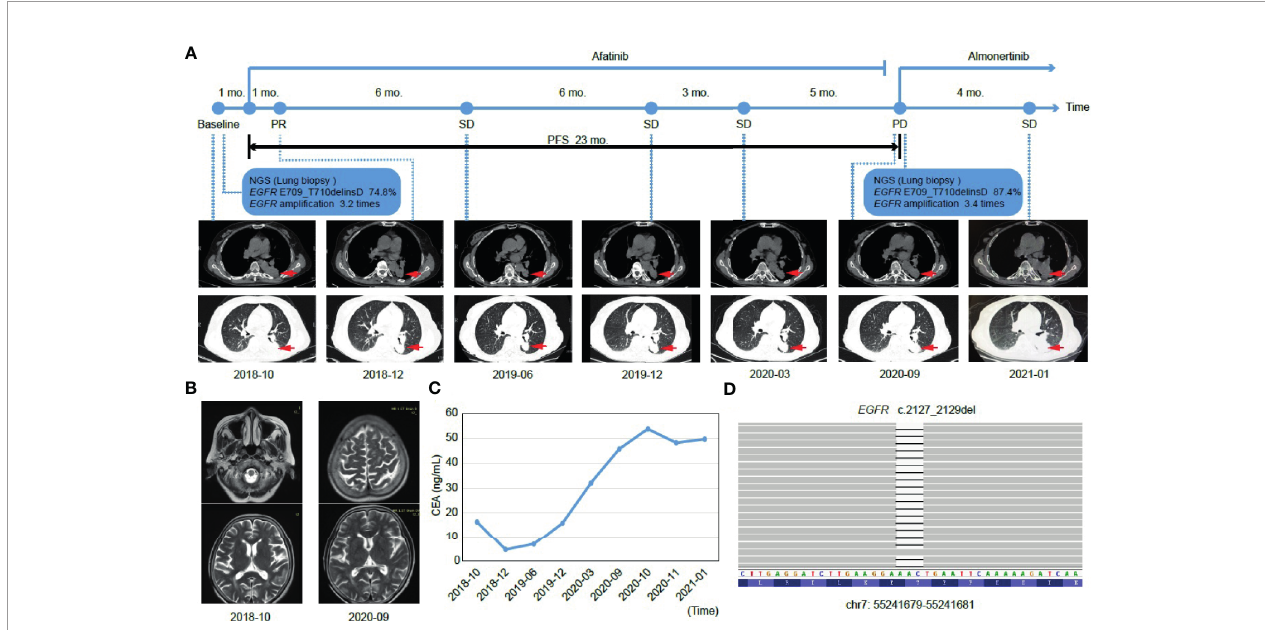
FIGURE 1 | Tumor progression of the patient before and after treatment. (A) The timeline of therapies and tumor progression are indicated (Top). CT images revealed lesions in lower left lung. The tumor is indicated by red arrows. PFS, progression-free survival; PR, partial response; SD, stable disease; PD, progressive disease; NGS, next-generation sequencing; mo., months. (B) Brain MRI scans revealed no metastasis before (October 2018) and after (September 2020) treatment. (C) Line chart showing changes in the levels of the serum tumor biomarker, CEA (carcinoembryonic antigen) during the course of treatment. (D) The EGFR p.E709_T710delinsD mutation was visualized by IGV software. Deletions are indicated with a black dash ( –